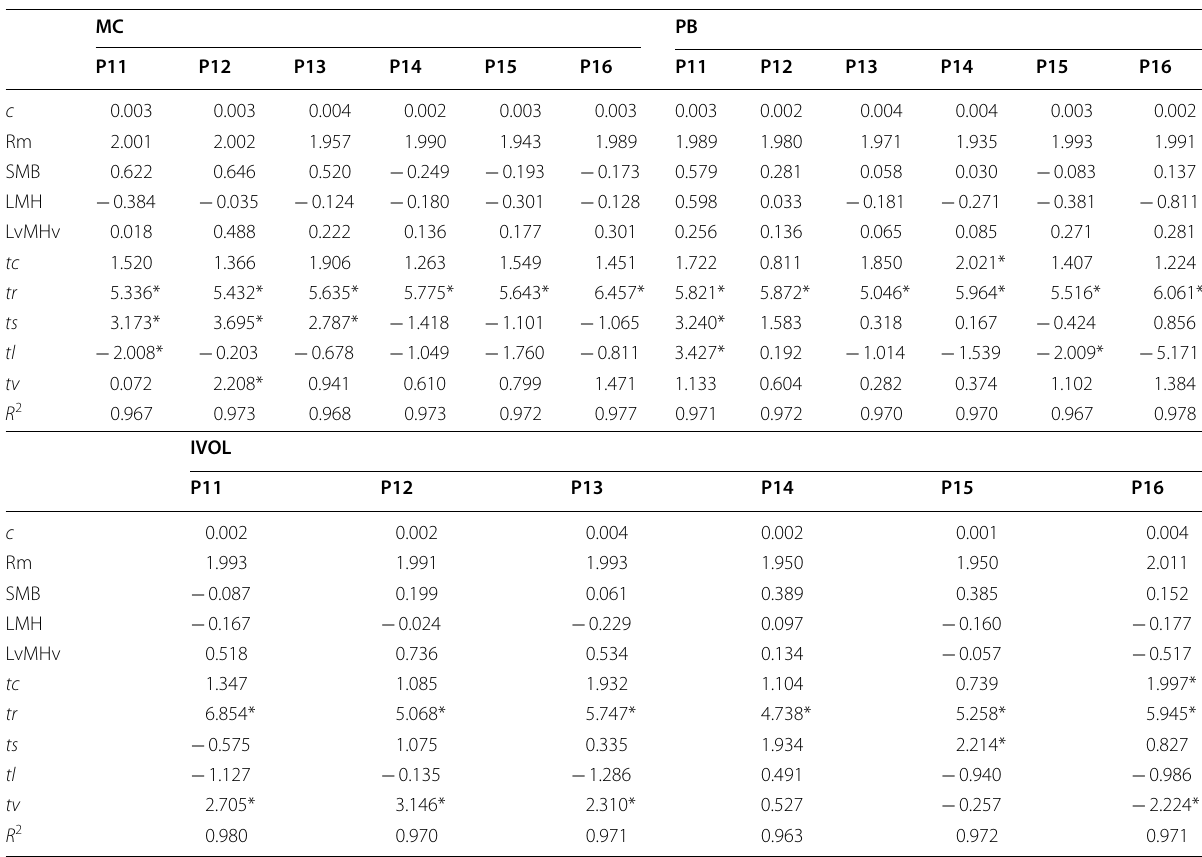
Table 7 Regression results of four-factor model for six portfolios R Pt − R Ft = a + b ( R Mt − R Ft ) + s SMB t + l